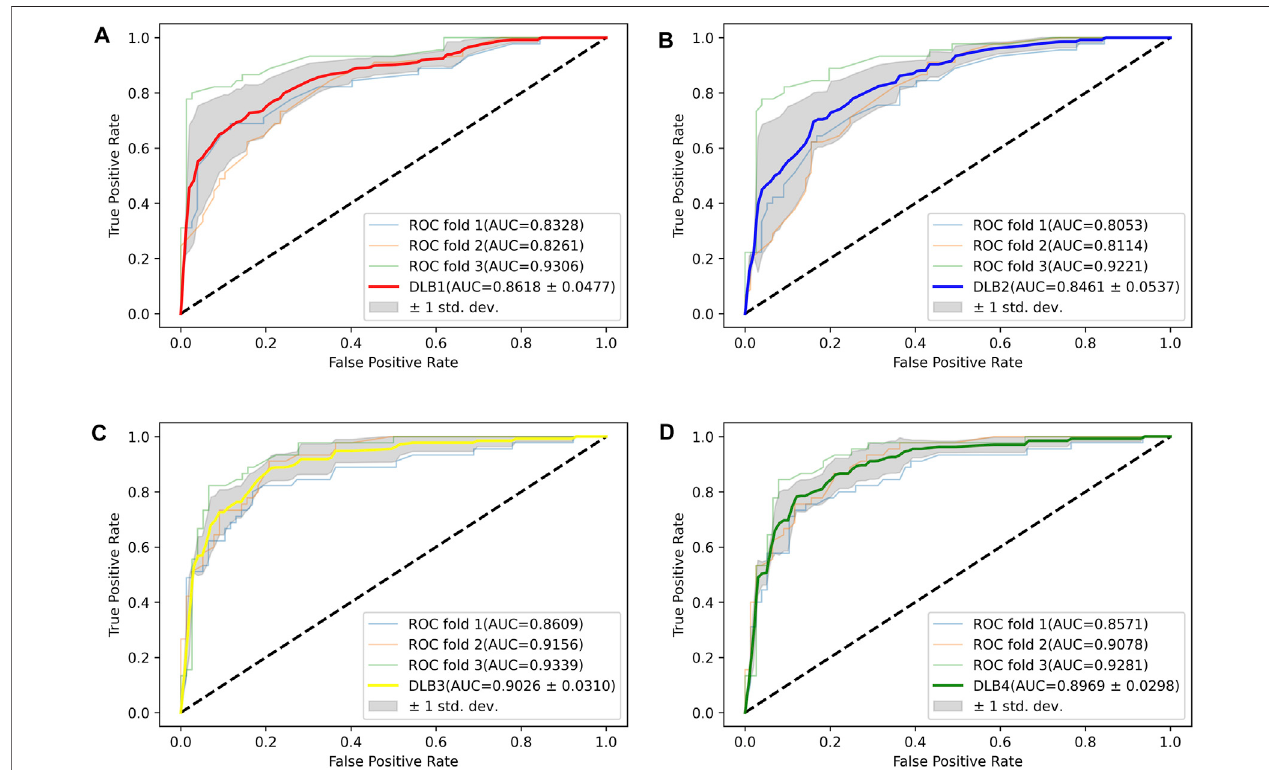
FIGURE3 | ROCcurvesforfour models inthe training set. (A) ROC curves ofDLB1. (B) ROC curves ofDLB2. (C) ROCcurves ofDLB3. (D) ROCcurves ofDLB4.